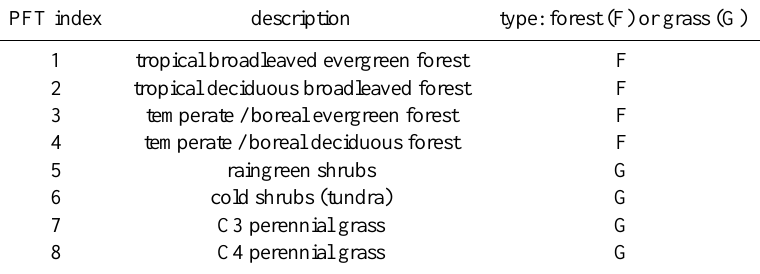
Table 1. Plant functional types considered by JSBACH. These include different types of evergreen and deciduous forest, shrubs and grasses. The rightmost column indicates to which generalized vegetation type (forest or grass) a PFT